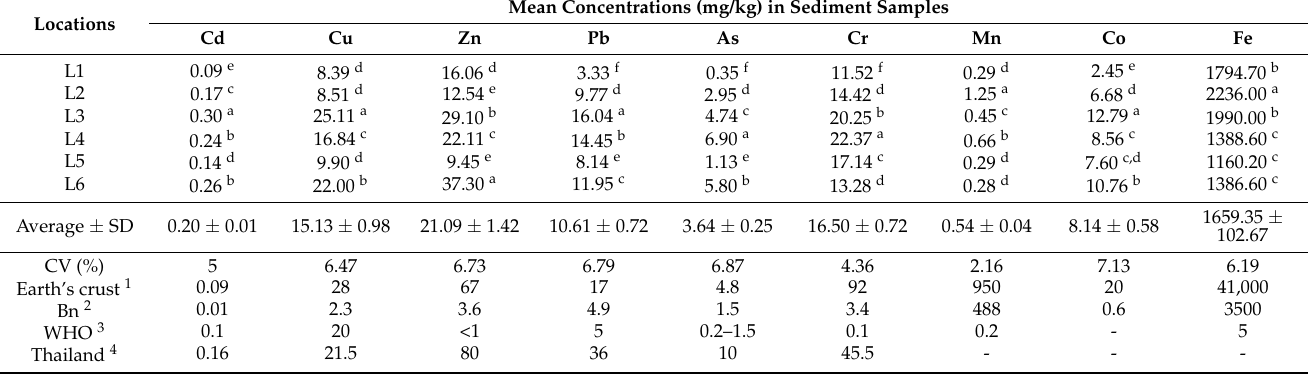
Table 1. Heavy metal concentrations in the sediment of the Chan Thnal Reservoir and the accept- able